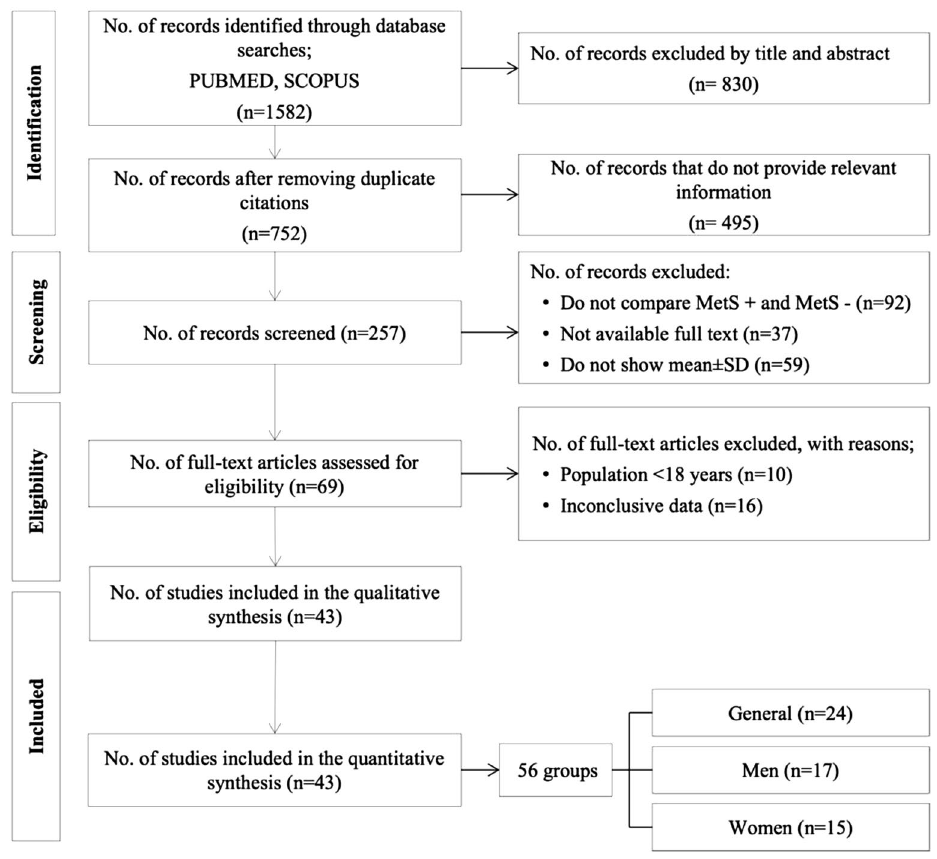
Figure 1. PRISMA flowchart. MetS: metabolic syndrome; SD: standard